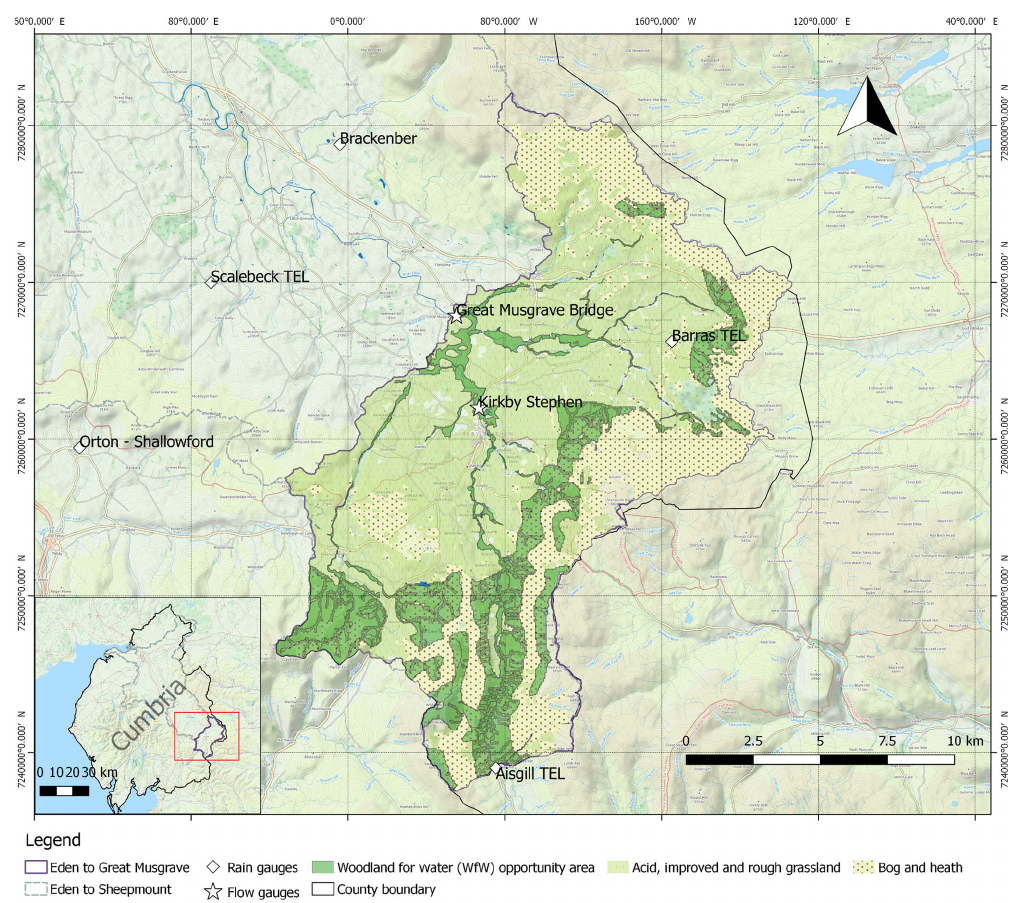
Figure 3. Study catchment, the Eden headwaters to Great Musgrave Bridge (223km 2 ), showing context within Cumbria, UK, predominant land cover and location of TBR rain gauges and gauging stations. Woodlands for Water tree planting opportunity areas are shown. These were applied in another application of the NFM modelling framework developed for the project described, which are not discussed in detail